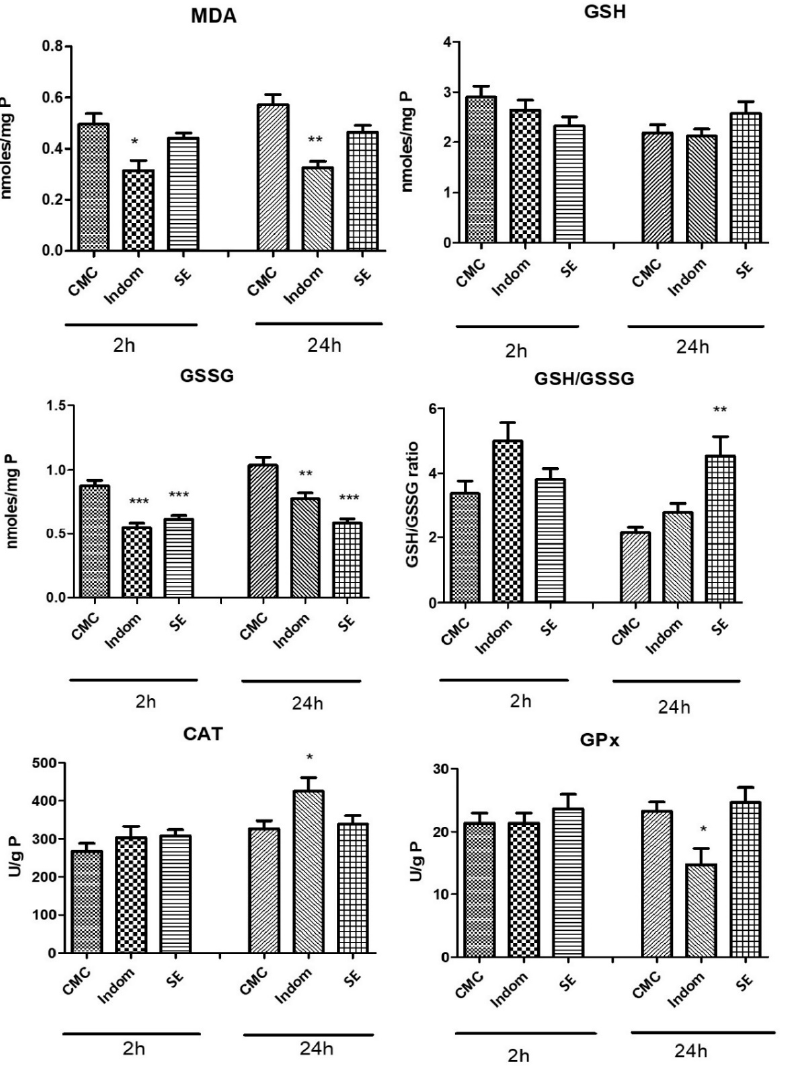
Figure 1. Soft paw tissue levels of MDA, GSG/GSSG ratio and the activity of CAT and GPx at 2, 24 h after carrageenan injection, in rats pretreated with SE extract. Values are means ± SD. Statistical analysis was done by a one-way ANOVA, with Tukey’s multiple comparisons post-test (* p < 0.05 ** p < 0.001 and *** p < 0.0001, all treated groups vs. control (CMC) group).